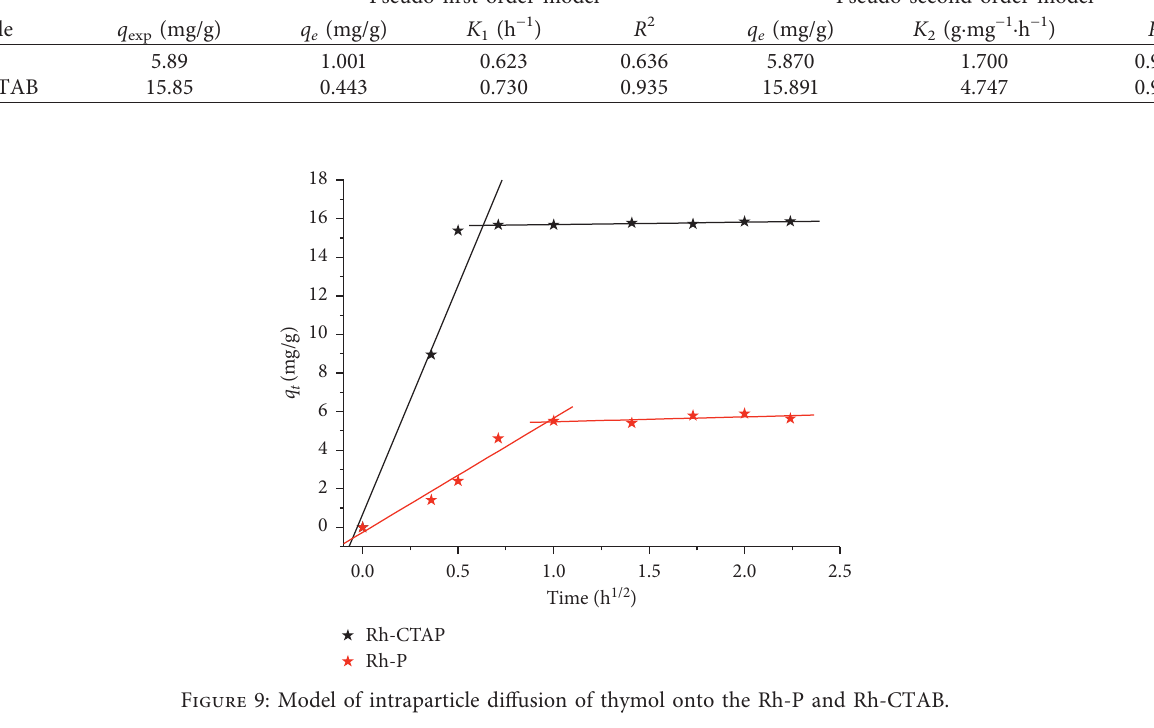
Figure 8: Linear representation of the kinetic model: (a) pseudo-first-order and (b) pseudo-second-order models for adsorption of thymol onto the Rh-P and Rh-CTAB. Table 5: Pseudo-first-order and pseudo-second-order kinetic parameters for the adsorption of thymol onto the Rh-P and Rh-CTAB. Pseudo-first-order model